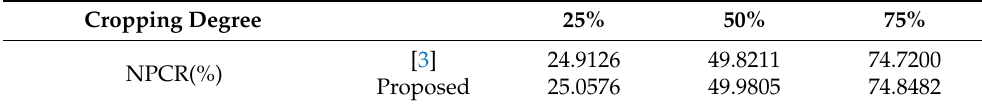
Figure 13. ( a – c ) are are the restoration results after 25%, 50%, 75% degree clipping using the method in [3]. ( d – f ) are the restoration results after 25%, 50%, 75% degree clipping using the proposed method. Table 8. NPCR comparison after